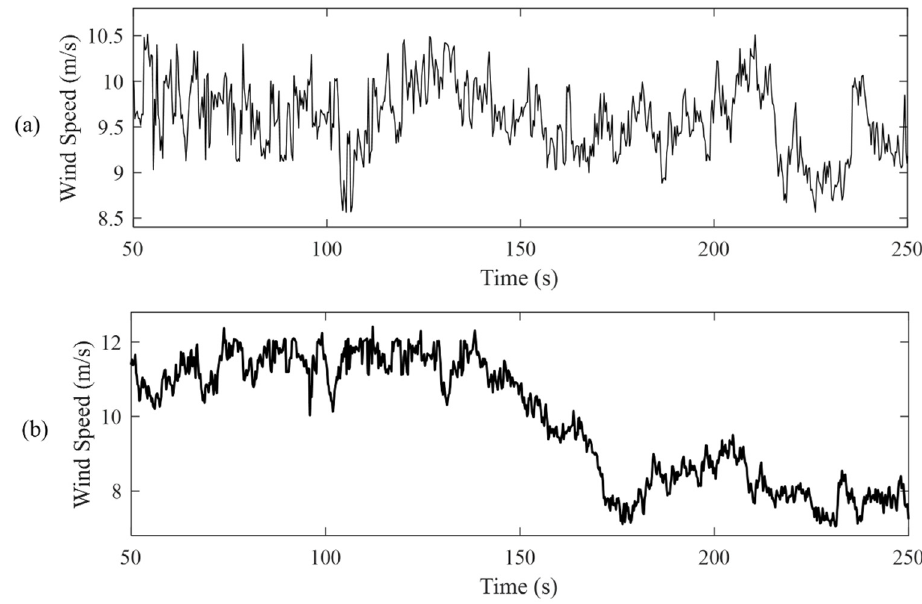
Figure 6. The variation of turbulent wind speed with time: ( a ) when the goal function of rotor speed is unimodal Gaussian distribution; ( b ) when the goal function of rotor speed is variable weight multi-Gaussian distribution.